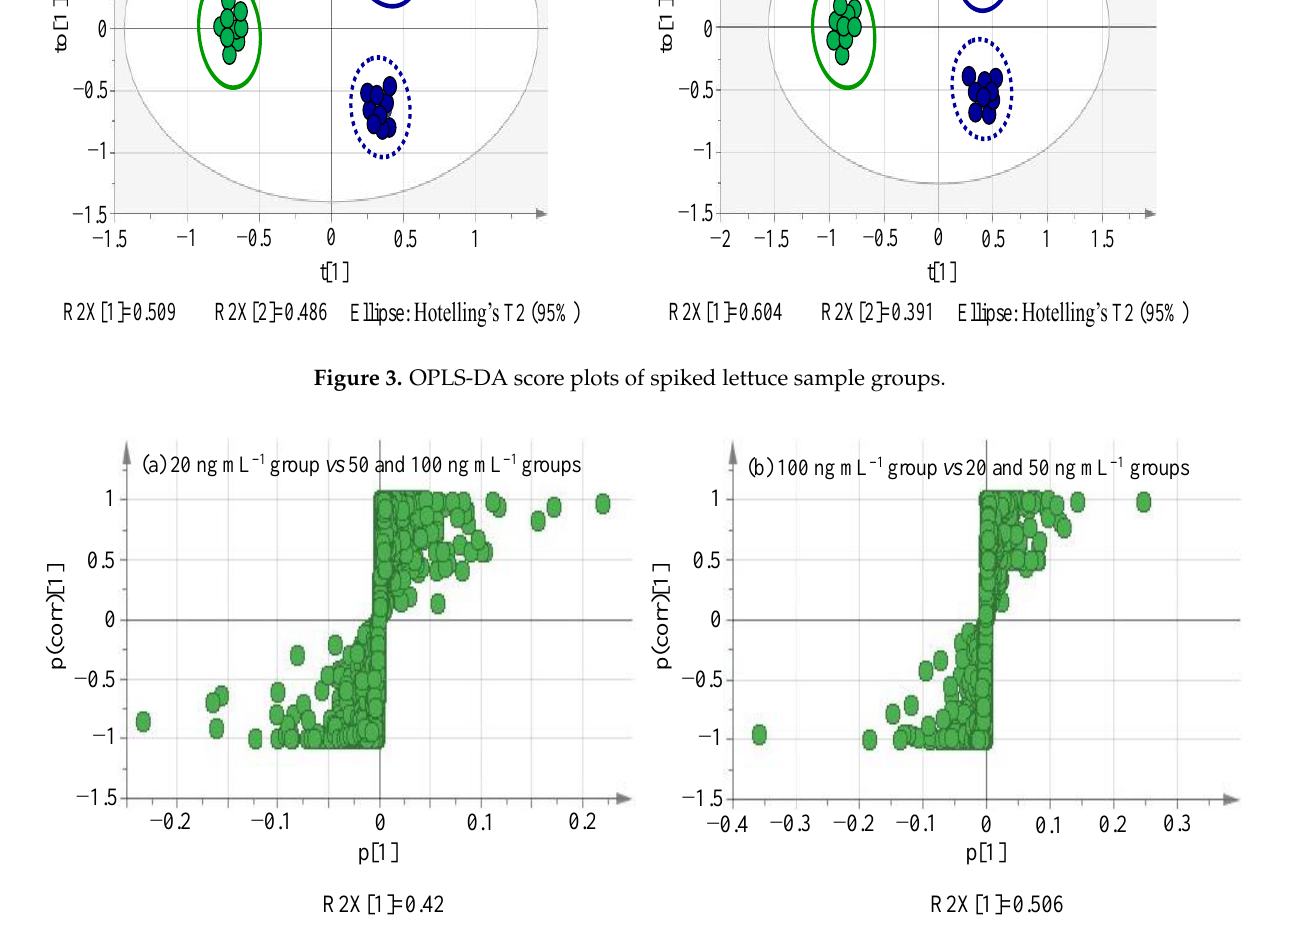
Figure 4. S-plot plots of spiked lettuce sample groups.